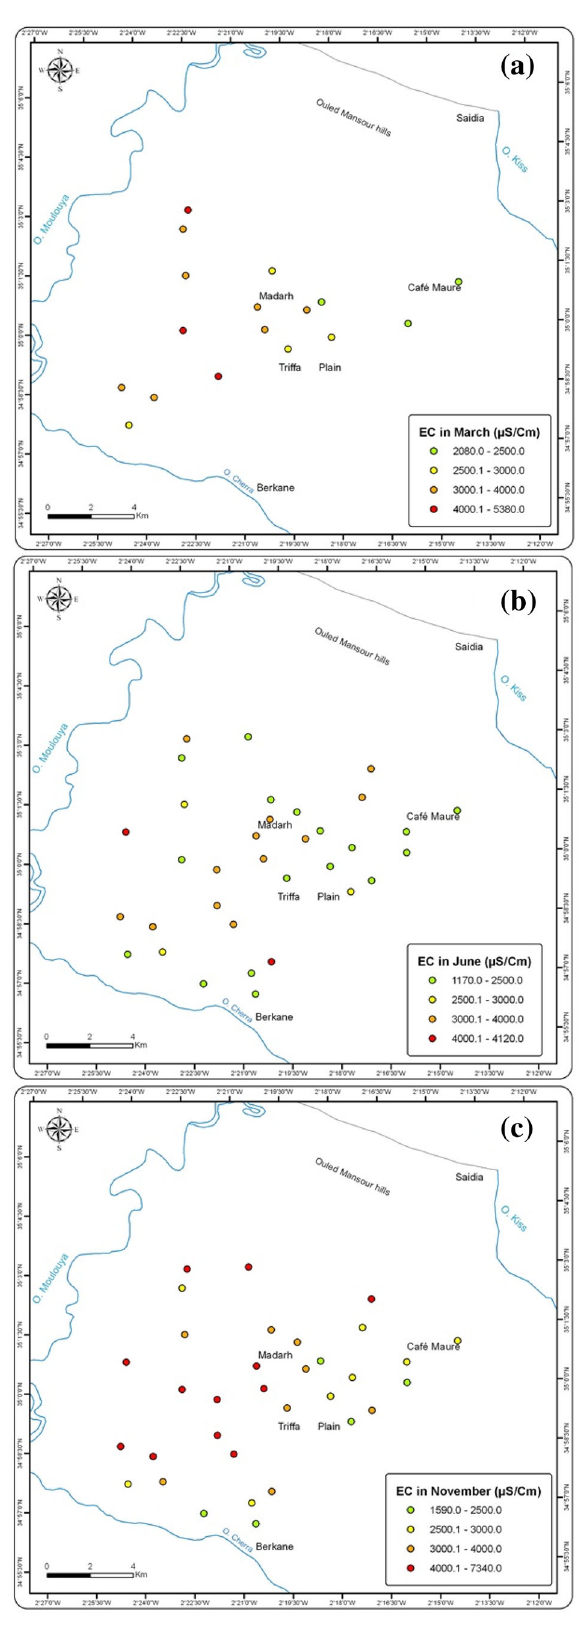
b Fig. 5 EC ( l S/cm) measured in the Triffa plain in a March, b June, and c November 2013, highlighting the changes in EC concentration between one period and another. The blue lines are